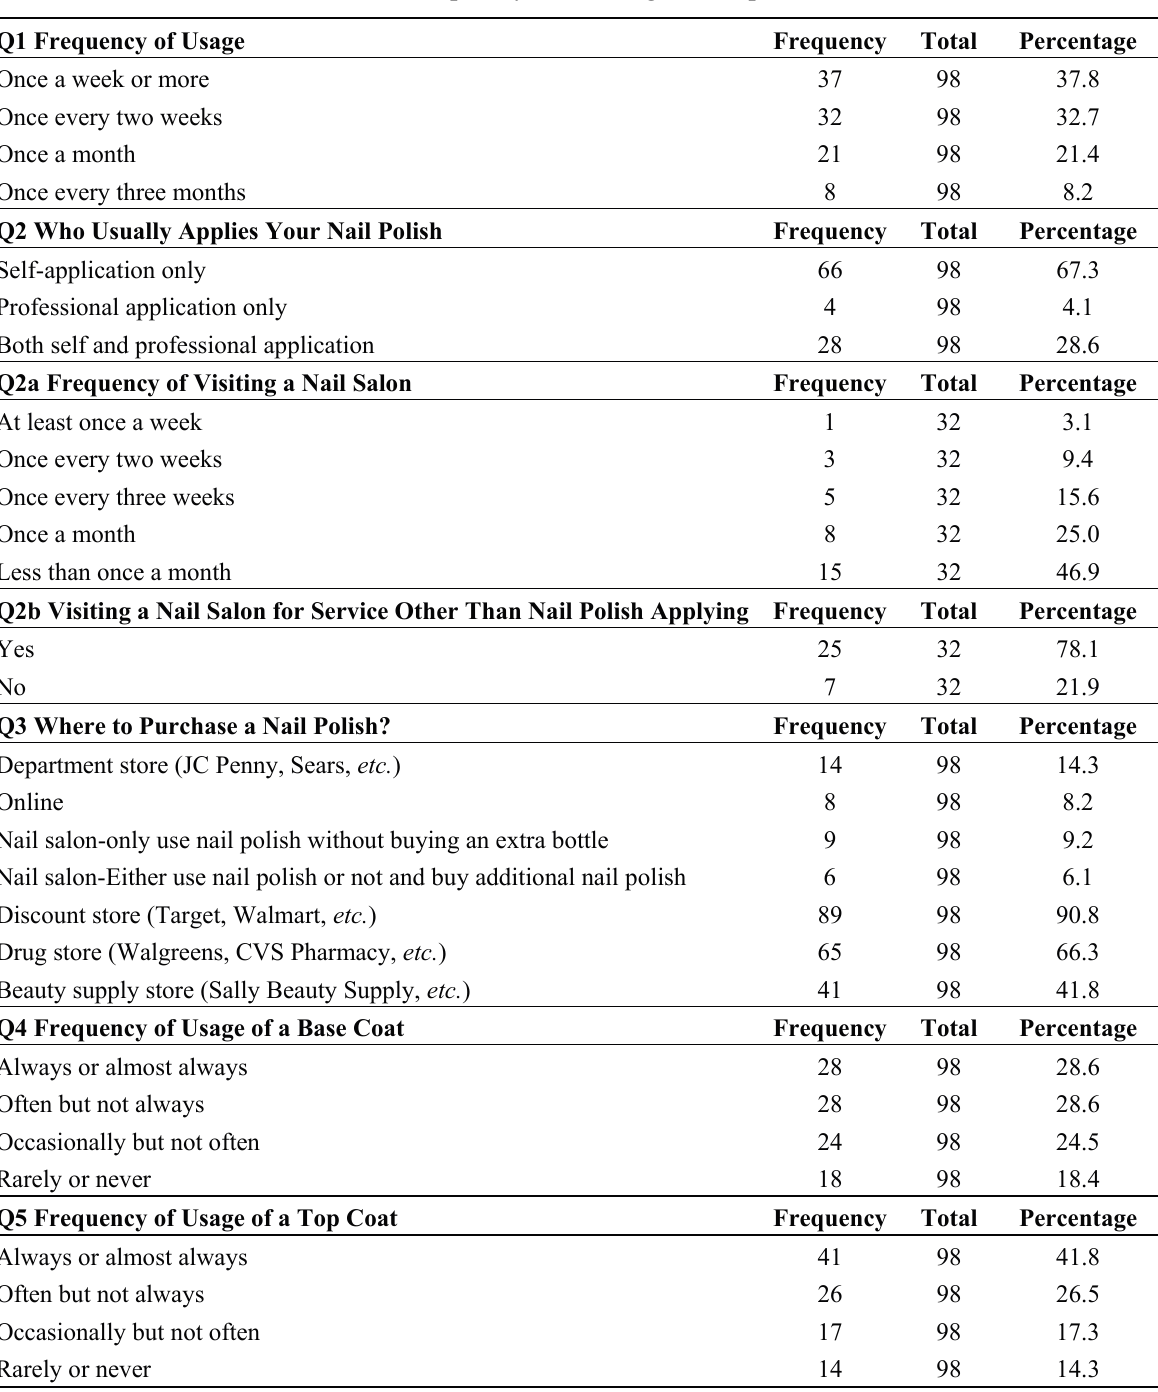
Table 1. Frequency table for general